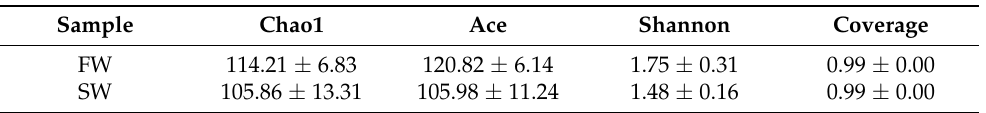
Values are means ± SD. Independent-sample t -test, n = 3 in each